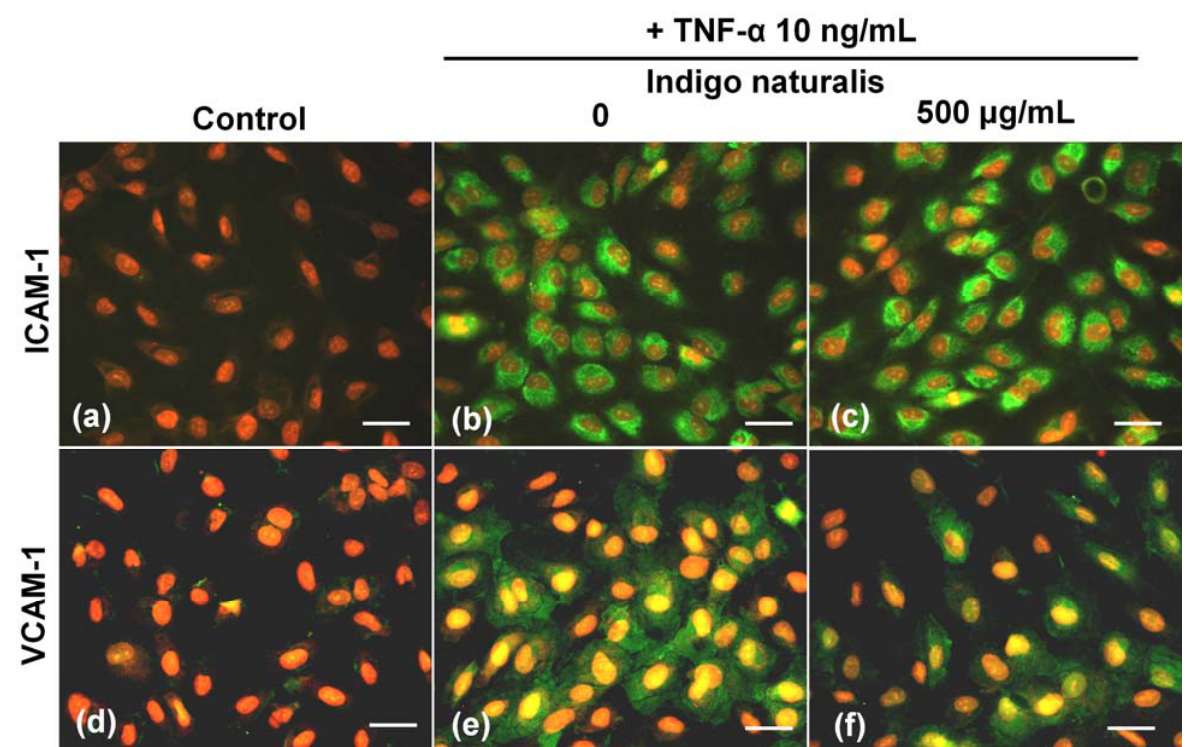
HUVEC were pretreated with indigo naturalis extract for 18 h and then stimulated with TNF- α for 6 h. (a, d) Control; (b, e) TNF- α (10 ng/mL) alone; (c, f) co-treated with TNF- α and indigo naturalis extract (500 μ g/mL). (a, b, c) ICAM-1 and (d, e, f) VCAM-1 were detected by immunofluorescence staining with anti- ICAM-1, and anti- VCAM-1 antibodies as well as FITC- conjugated secondary antibody (green fluorescence). Nuclei were stained with propidium iodide (orange fluorescence). The result shown is a representative of three independent experiments. Scale bar = 20 μ